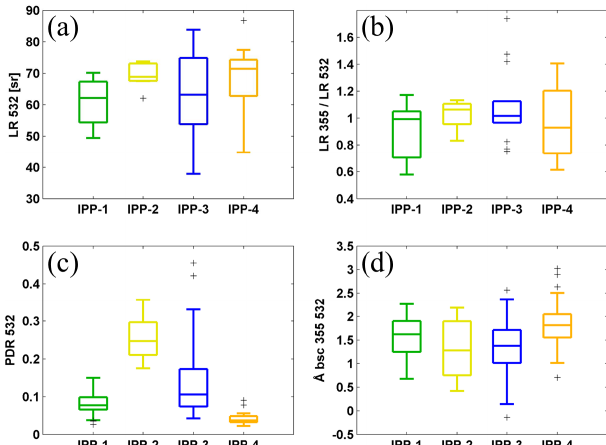
Figure 10. Box plots of (a) lidar ratio (LR) at 532nm and (b) ra- tio of LR at 355nm and LR at 532nm during night-time measure- ments. Box plots of (c) particle linear depolarization ratio (PDR) and (d) backscatter-related Ångström exponent between 355 and 532nm during all-day measurements. Mean values of the detected pollen layer for four IPPs are used. The horizontal line represents the median, the boxes the 25% and 75% percentiles, the whiskers the standard deviation, and the plus signs the